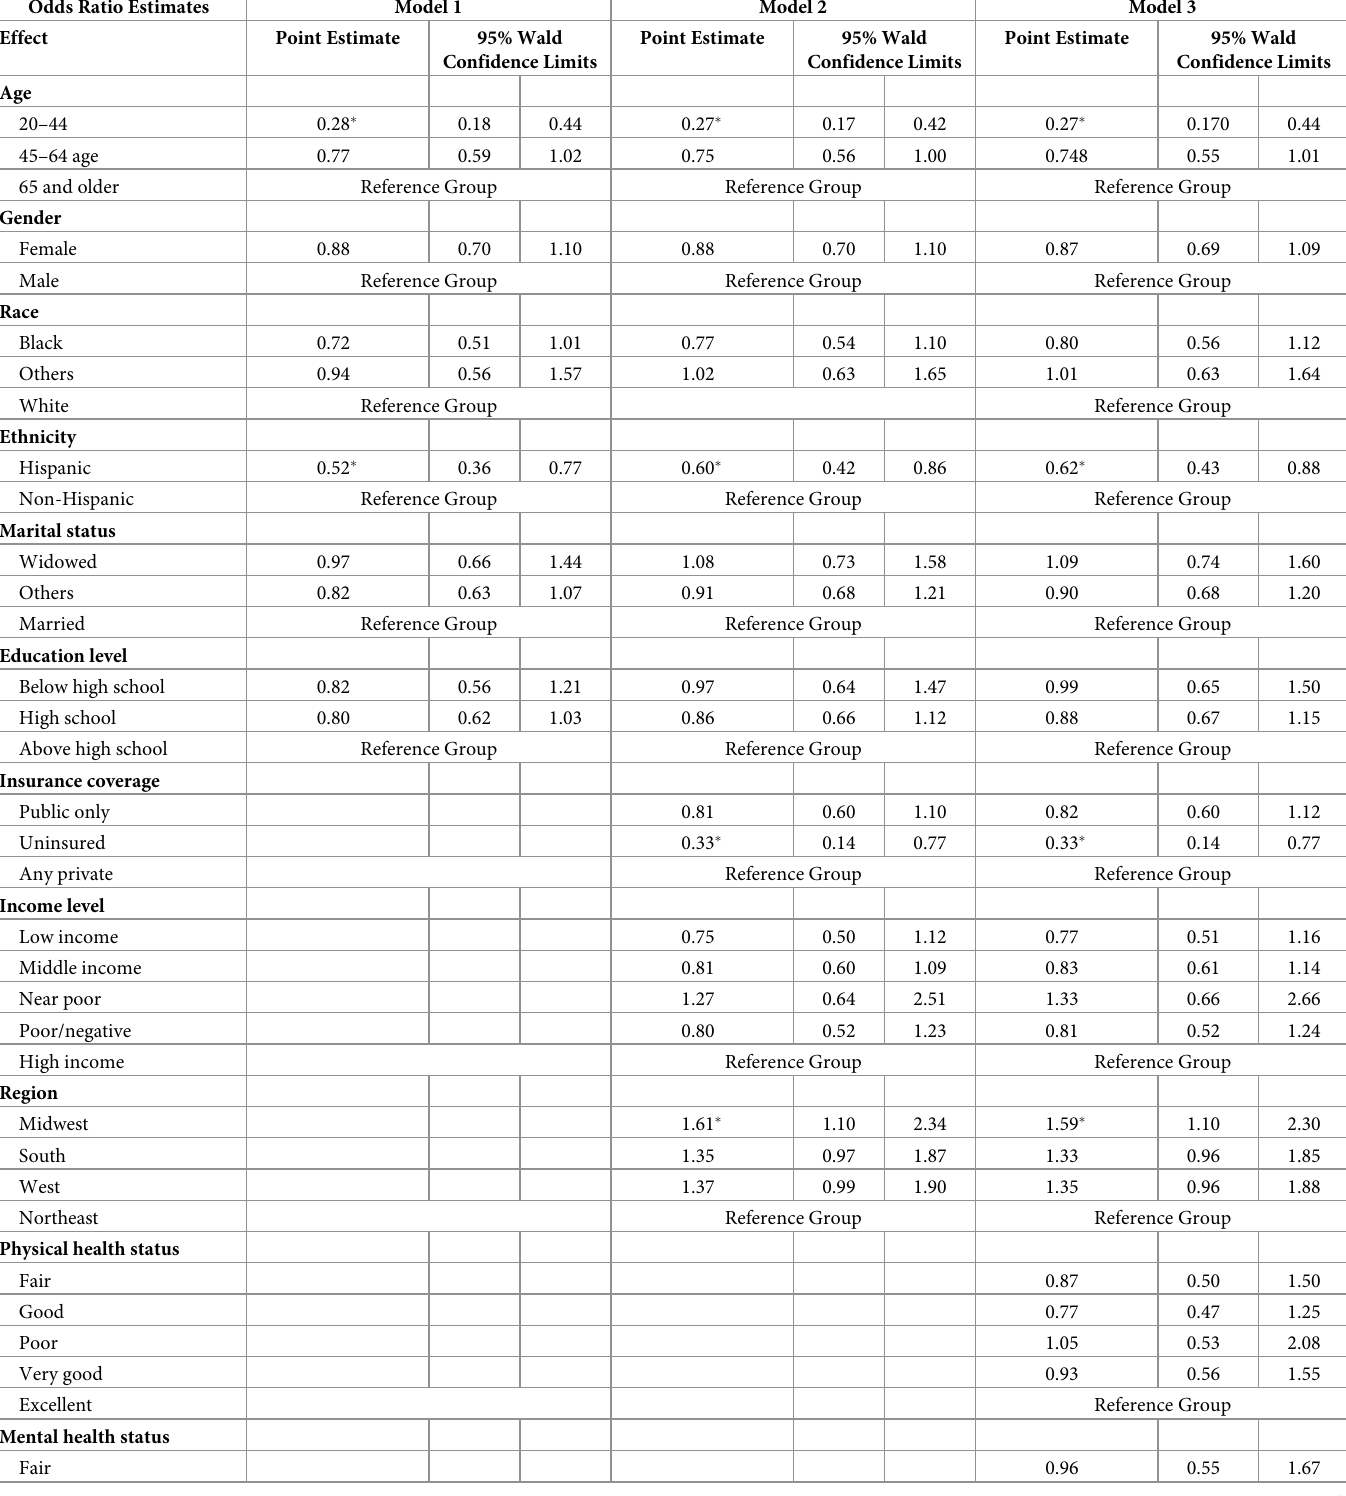
Table 4. Progressively adjusted logistic models of hyperlipidemic